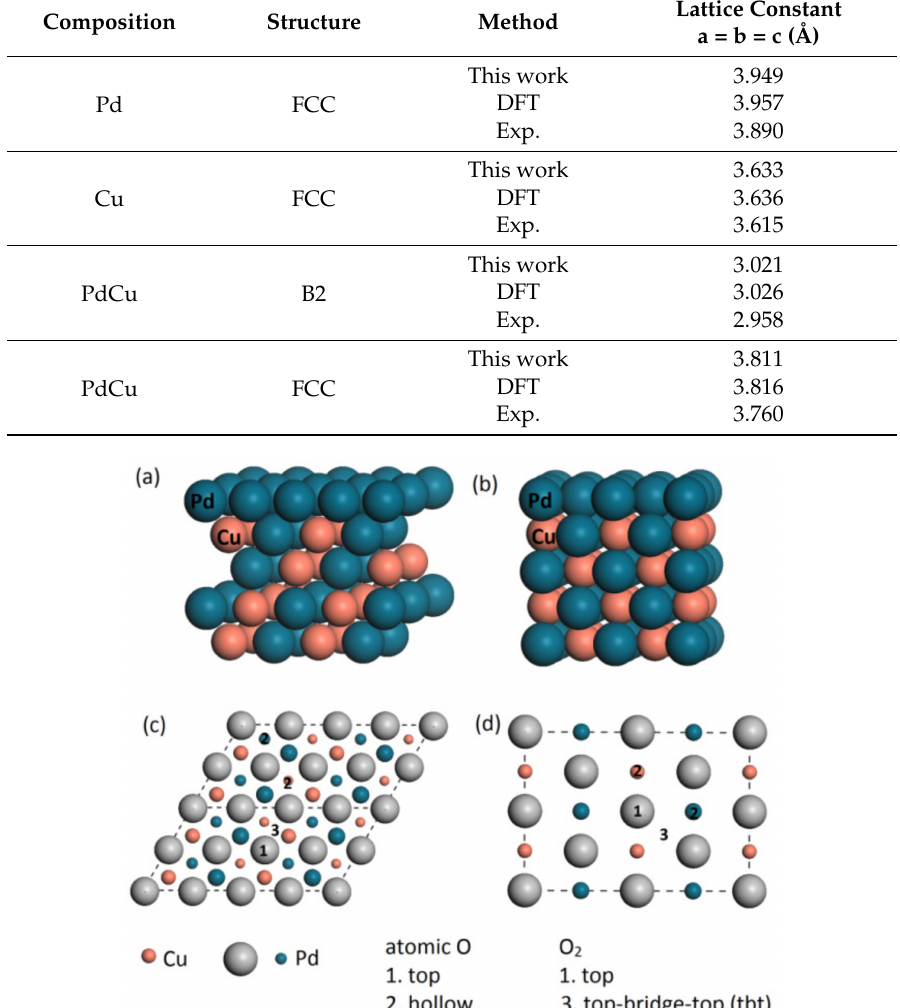
Figure 1. The configuration of side view of ( a ) Pd/Pd–Cu(111) alloy and ( b ) intermetallic Pd/Pd–Cu(110); and top view of ( c ) Pd/Pd–Cu(111) alloy and ( d ) intermetallic Pd/Pd–Cu(110). The atomic oxygen adsorption site, O 2 adsorption site are shown in Figure 1c,d. Regardless of the atom size, orange color represents Cu and ashen and dark blue color represent